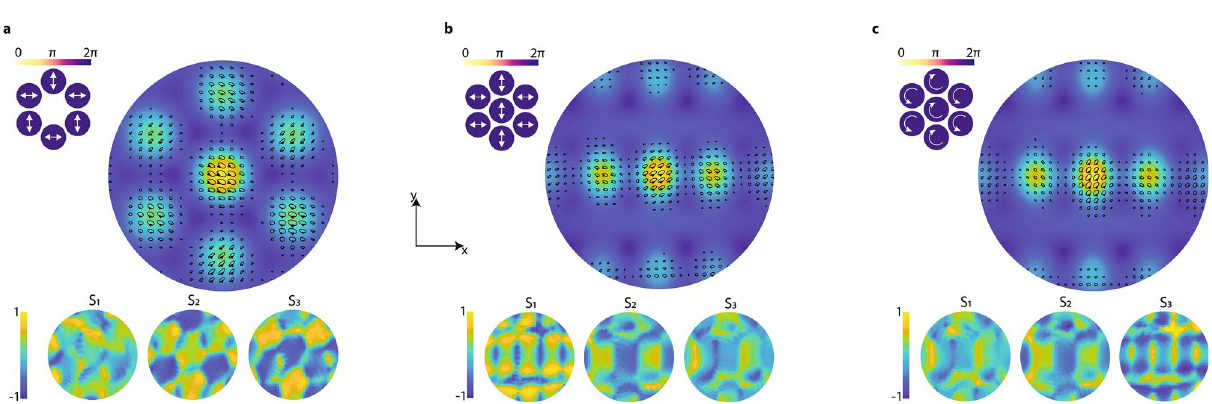
Figure 4. Experimental results of polarization topography evolution with corresponding near-field configurations (top left) and Stokes projections (bottom) for alternating linear ( a ), asymmetric linear ( b ), and asymmetric circular polarization coherent synthesis ( c